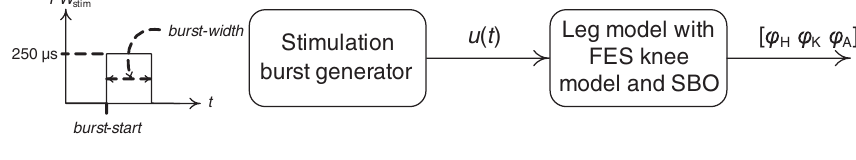
Fig. 7. Schematic of cycle-to-cycle control structure initialized/optimized with